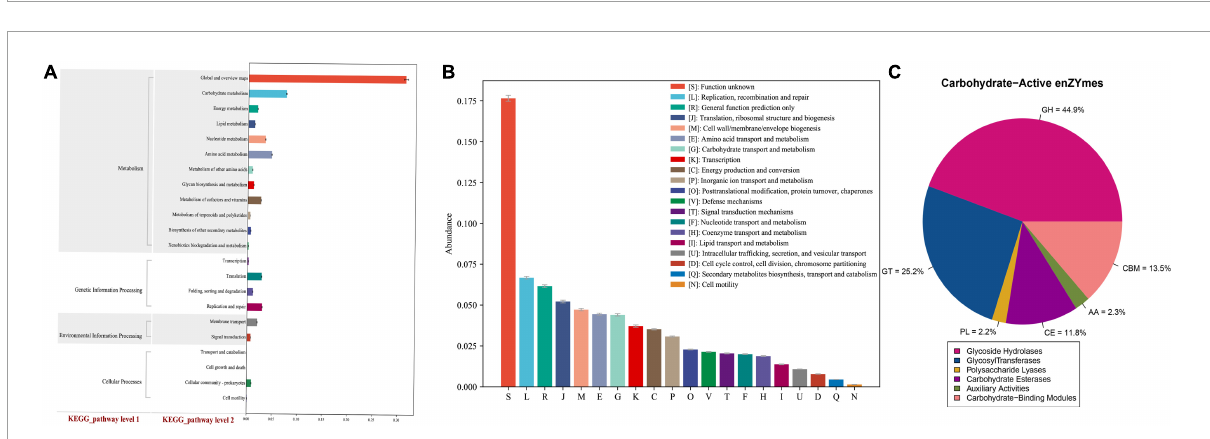
FIGURE4 Functional annotation. (A) Statistical map of KEGG metabolic pathway-related functional genes at the level 2, X -axis: the relative content of the corresponding functional gene number, Y -axis: the classification content of KEGG level 1 and level 2. (B) Histogram of eggNOG functional gene function classification, X -axis: the relative content of the corresponding functional gene number, Y -axis: the classification content of eggNOG. (C) Pie chart of the proportion of various carbohydrate